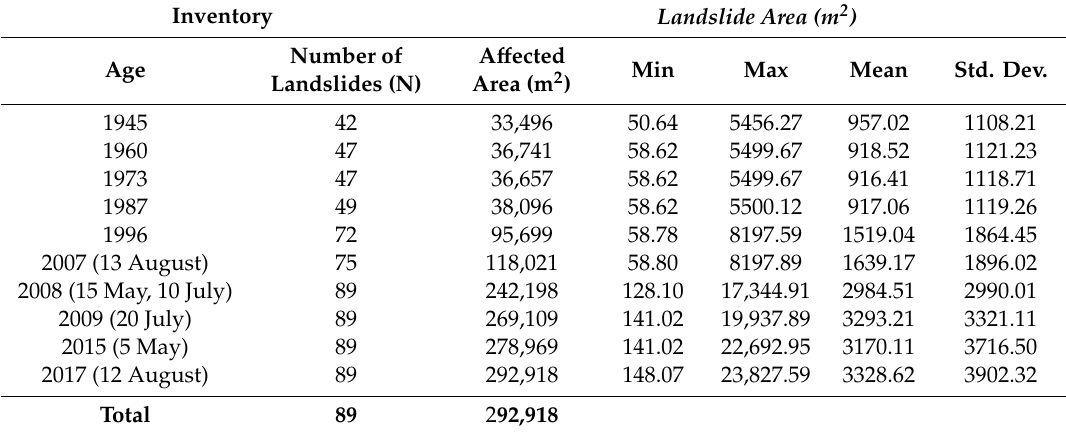
Table 3. Temporal and spatial characteristics of the landslide sites from visual